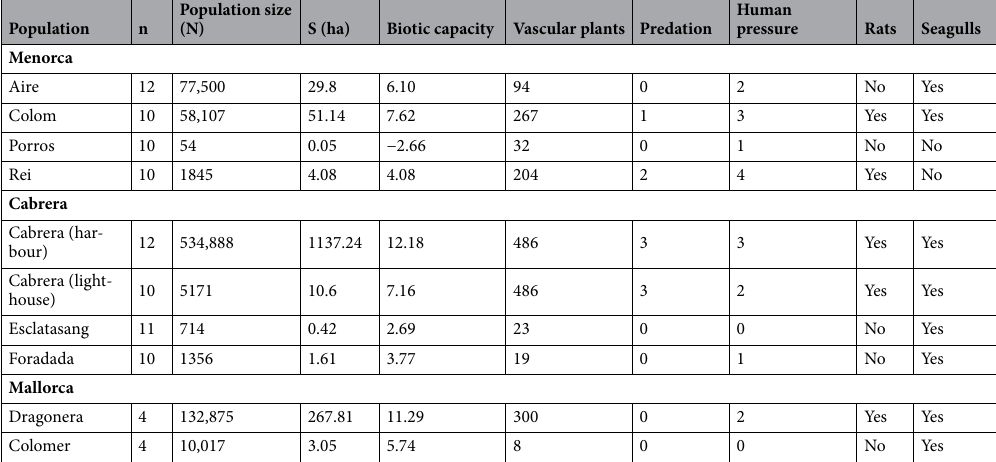
Table 2. Characteristics and environmental variables of the studied populations. n number of samples used for every population, S island surface area in hectares, predation indexes absence of terrestrial predators = 0; one occasional predators in the island = 1; one widespread predator was or is present in the island = 2; two frequent predators present in the island = 3, human pressure uninhabited island and very difficult access = 0; sporadic human presence and easy access = 1; regular human presence and easy access = 2; previous permanent human presence with constructions but with an actual protection = 3; present and past human presence =